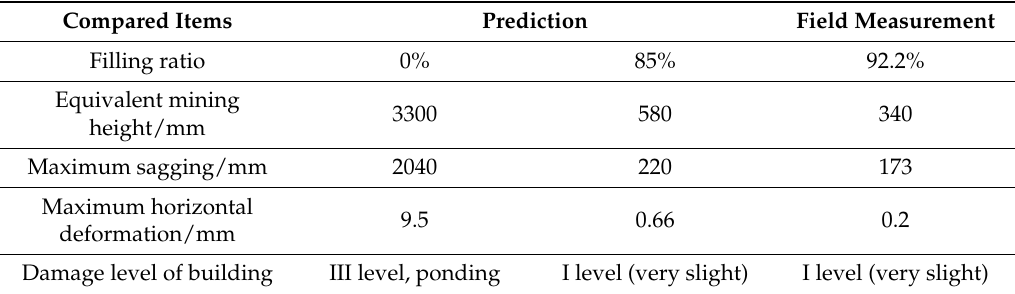
Table 3. Data of surface movement prediction and field measurement of Panel 13080.